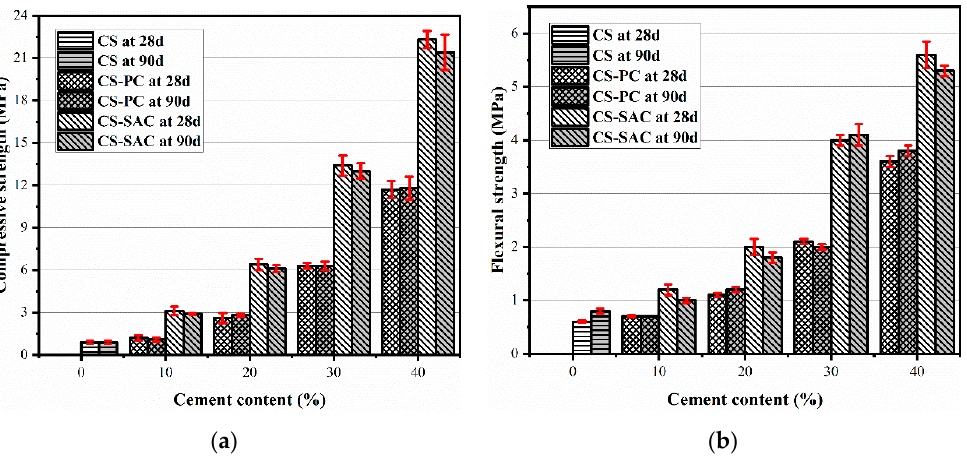
Figure 2. Compressive and flexural strength of blended mortars: ( a ) Compressive strength; ( b ) flexural